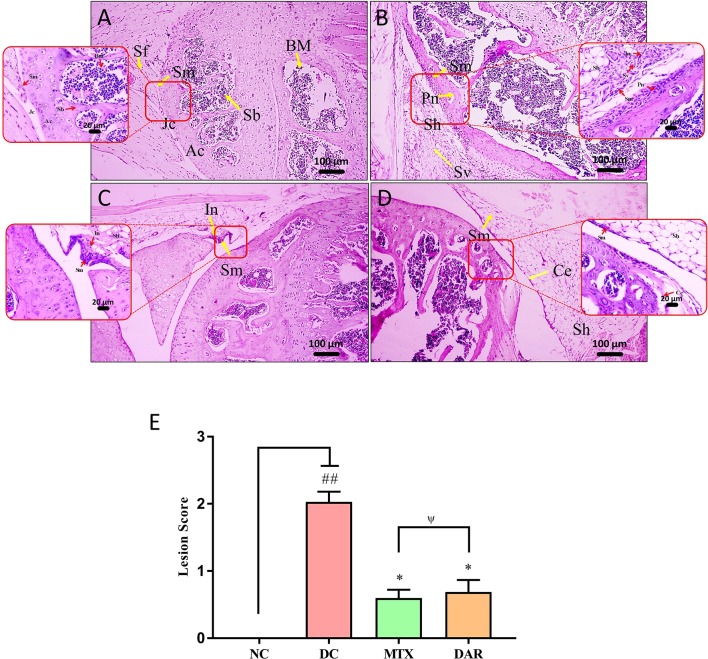
H&E stained histopathological analysis of knee joints. Histopathological images of H&E stained knee joints taken at low (100×) and high (400×) magnification showing: (A) NC animal representing articular cartilage (Ac), synovial membrane (Sm), spongy bone (Sb), bone marrow cells (Bm), and joint cavity (Jc). (B) C-Ab and LPS stimulated DC animal showing moderately enlarged synovial membrane (Sm), hyperplastic synovium (Sh), increased synovial vascularity (Sv), inflammation (In), and Pannus formation (Pn). (C) Treatment of the CAIA mice with DAR showed mildly enlarged Sm, Sh, and cartilage erosion (Ce). (D) Treatment of the CAIA mice with MTX showed mildly enlarged Sm, Sh, increased Sv, and induction of inflammation (In). (E) Total lesion score analysis showed that the treatment of CAIA mice with DAR or MTX showed a significant reduction in the lesion score. Non-parametric Kruskal–Wallis analysis was used to calculate the statistical difference in NC versus DC (p-value ## < 0.01), MTX or DAR treatment versus DC (p-value * < 0.05; ** < 0.01), and comparison between MTX and DAR treatments [p-value ψ > 0.05 (non-significant)].